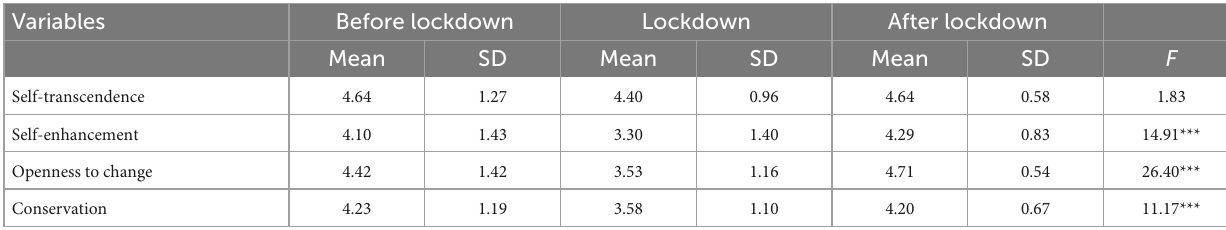
TABLE 2 Individual level higher-order dimensions of personal values before the lockdown, during the lockdown, and after the lockdown. Variables